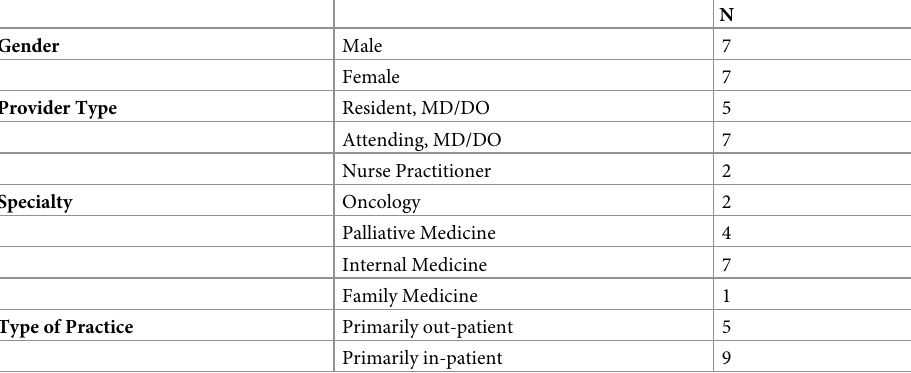
Table 1. Characteristics of participants (N =